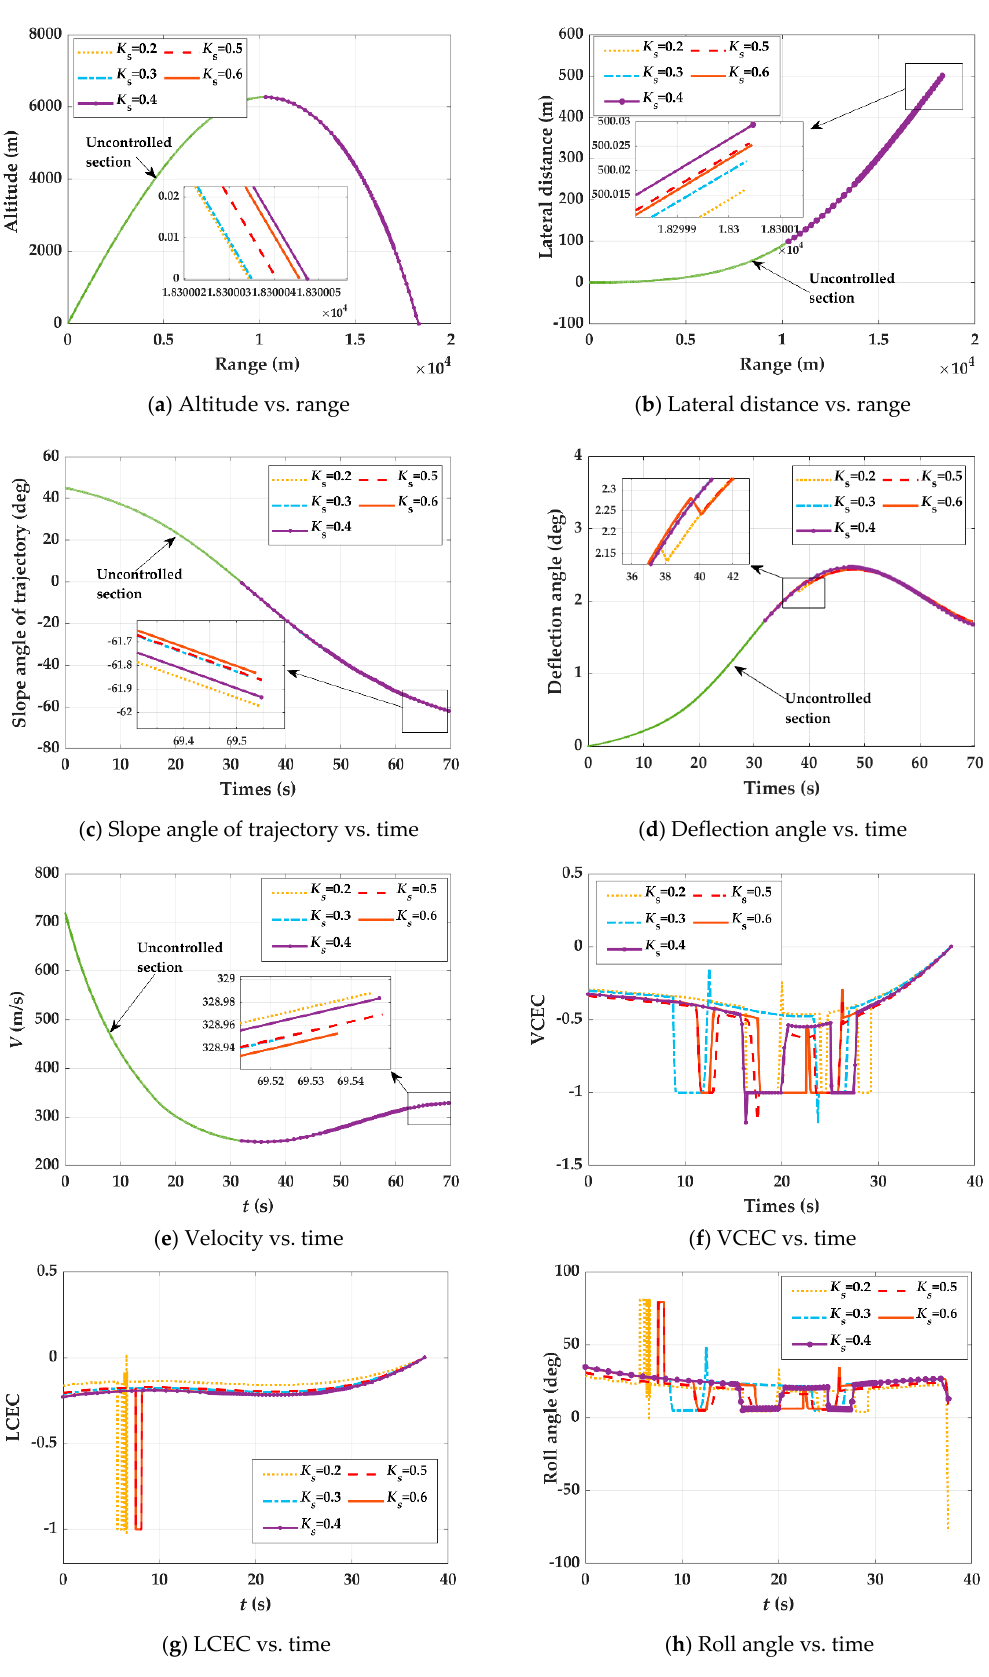
Figure 7. Trajectory optimization of different aspect